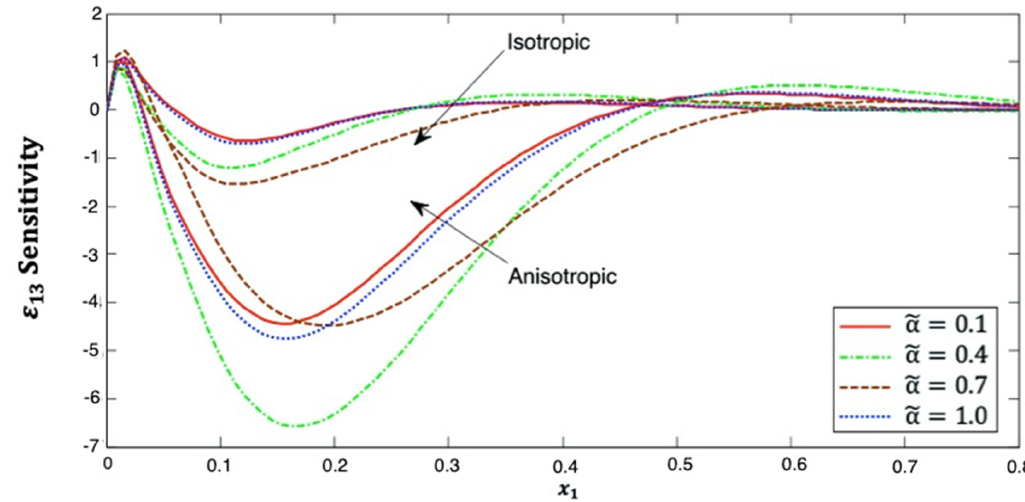
Figure 11. Distribution of the ε 13 sensitivity along x 1 –axis in isotropic and anisotropic FRP composites for various fractional-order values.